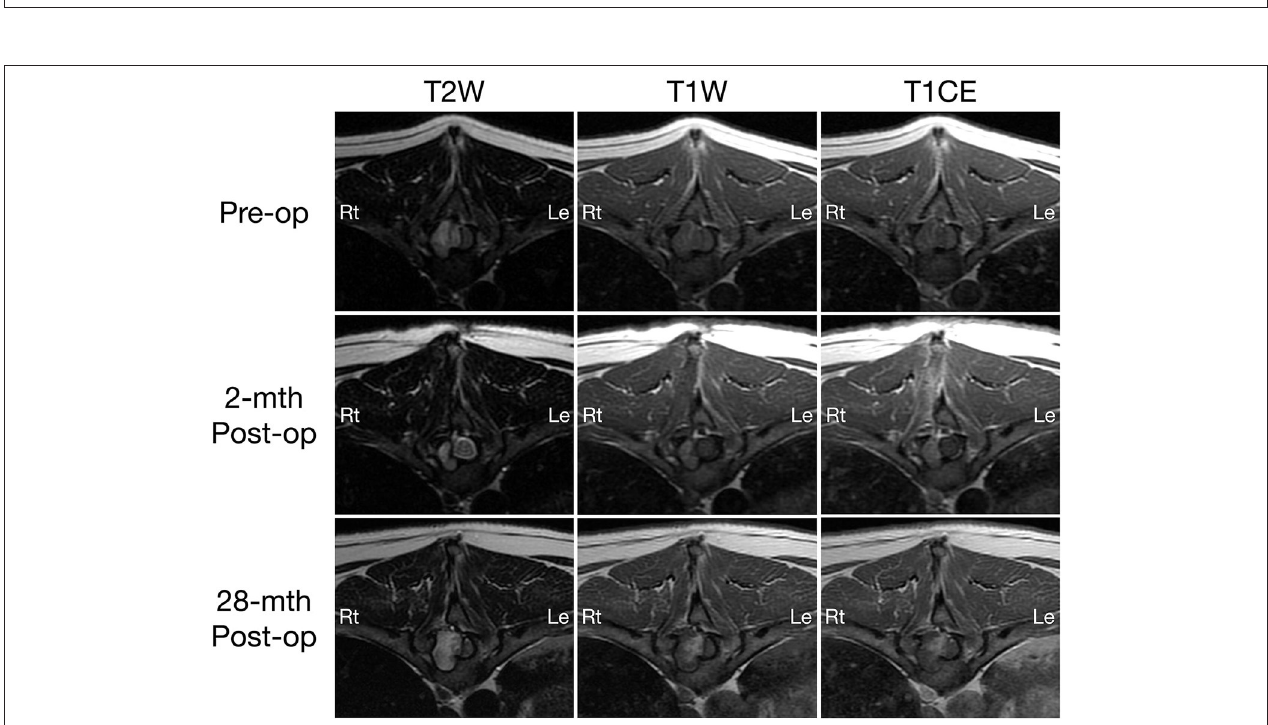
FIGURE 2 | Transverse T2-weighted (left column) and pre- (middle column) and post-contrast T1W (right column) MRI images of a dog with extradural spinal epidermoid cyst; pre-operative (top row) and 2-month (middle row) or 28-month post-operative (bottom row) at the level of T10 vertebral body. The volume of the mass was reduced 2-month after surgery (middle column), but regrowth is observed 28 months post-surgery with progressive bone resorption and spinal cord compression (bottom row).